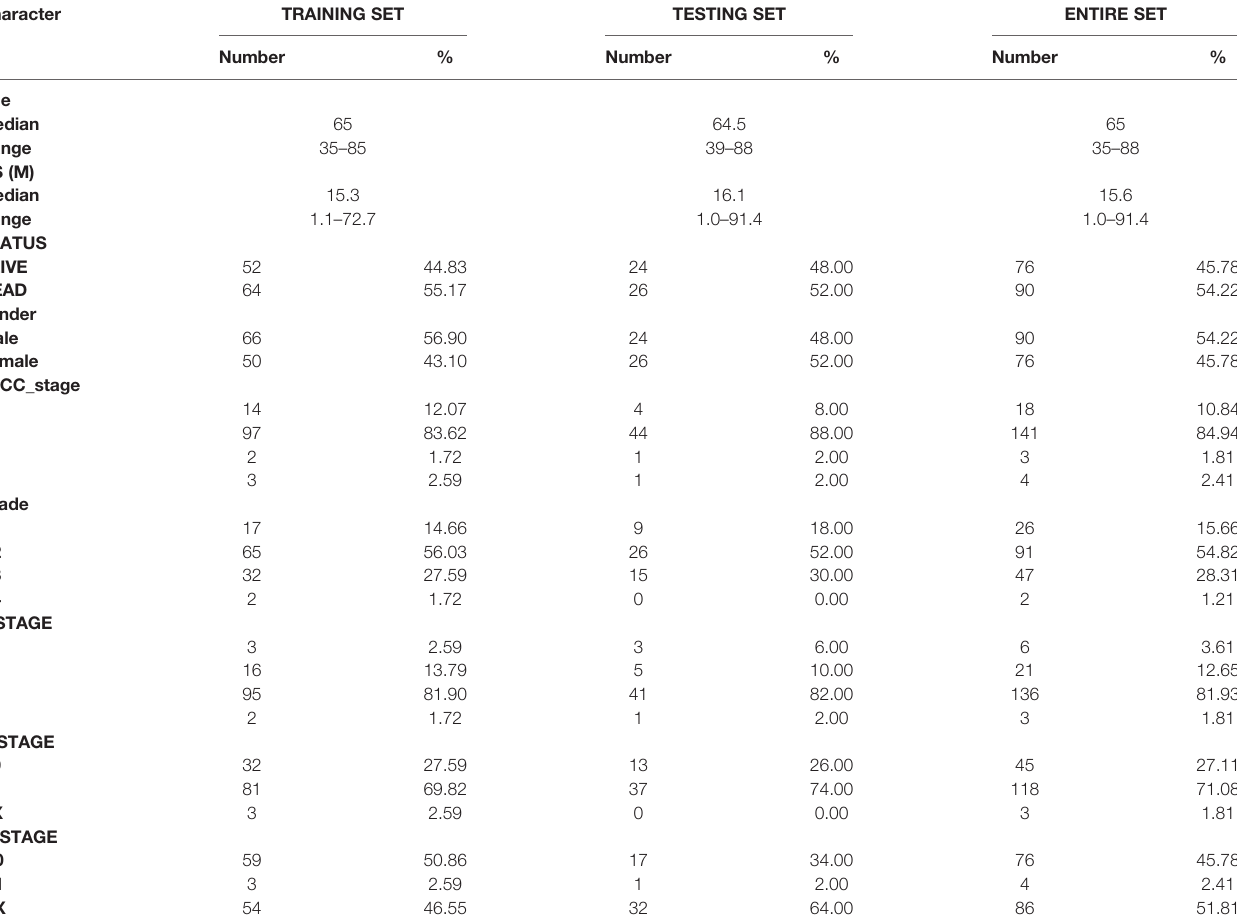
TABLE 1 | Clinical and pathologic information of training set, testing set and entire set.